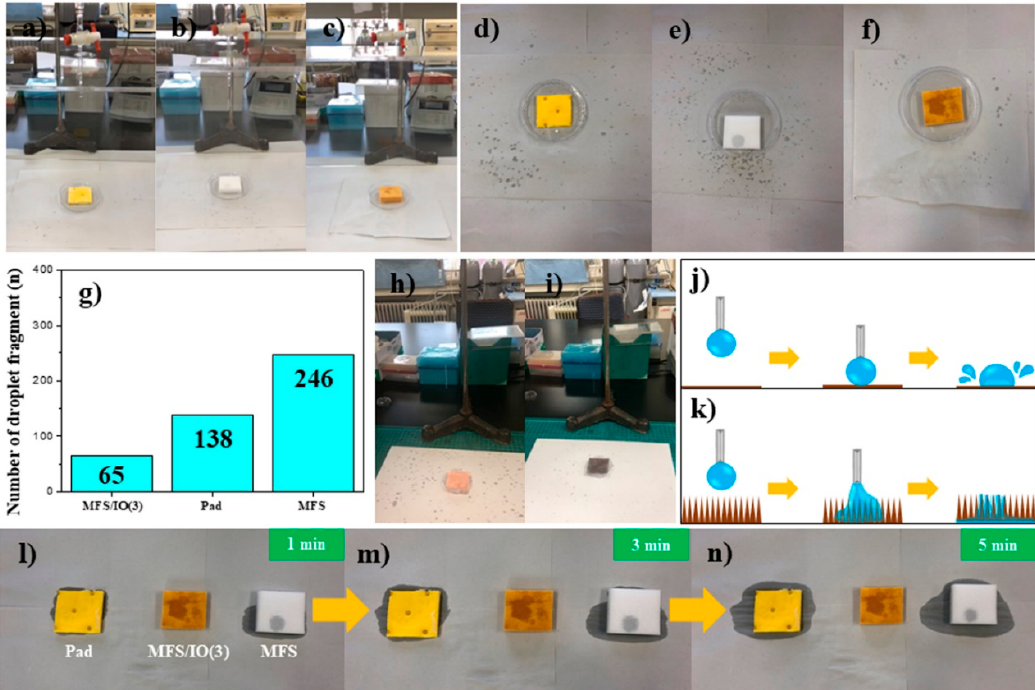
Figure 7. Test for the droplet fragments that bounced from the surface of each absorbent: ( a , d ) pad, ( b , e ) MFS, and ( c , f ) MFS / IO(3). ( g ) Number of droplet fragment particles formed from the surface of each absorbent upon acid solution dropping. Superhydrophilic Cu meshes with ( h ) smooth and ( i ) needlelike surface morphologies. Schematic representation of a plausible explanation for the droplet behaviors on ( j ) smooth and ( k ) needle-like surfaces. After dropping the acid solution for 1 min on each absorbent, the solution released from each absorbent was monitored as a function of time: ( l ) 1 min, ( m ) 3 min, and ( n ) 5 min. (left) Pad, (middle) MFS / IO(3), and (right) MFS.